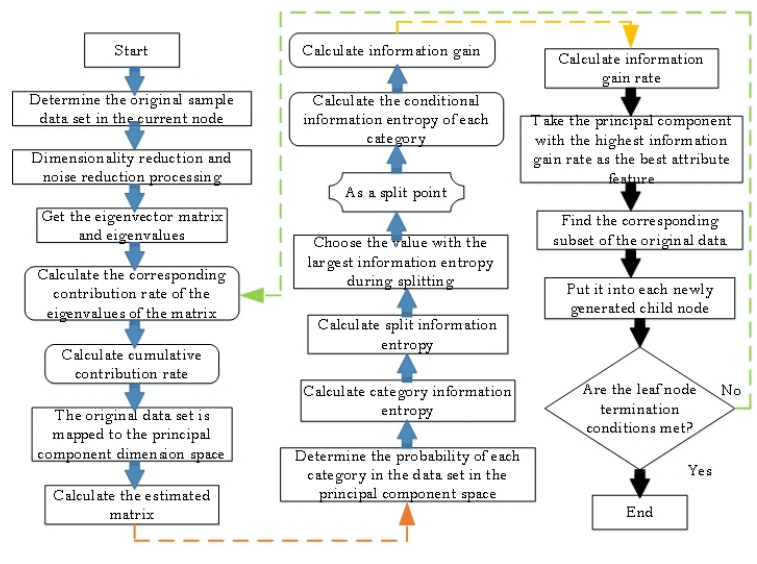
Fig. 4. Flow chart of the subset entropy attribute recursive decision tree algorithm in the decision tree construction